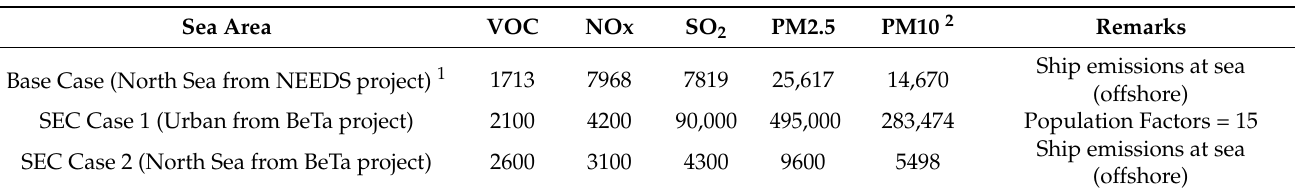
Table 6. Estimated social and environmental costs for air pollution from ships used in this study [EUR 2000